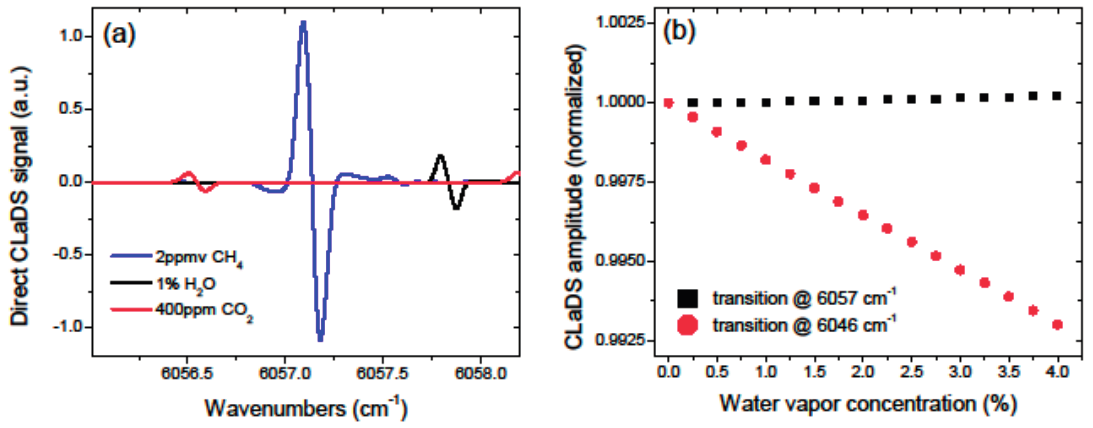
Figure 3. ( a ) Simulated CLaDS spectra of the three main atmospheric species in the 1651 nm (6057 cm − 1 ) region; ( b ) Impact of the water vapor concentration on the peak amplitude of the CH 4 CLaDS signal calculated for the transitions at 6057 and 6046 cm − 1 (both have similar linewidths, thus double sideband (DSB) spacing of Ω = 1.2 GHz was used for calculating the CLaDS signal in both